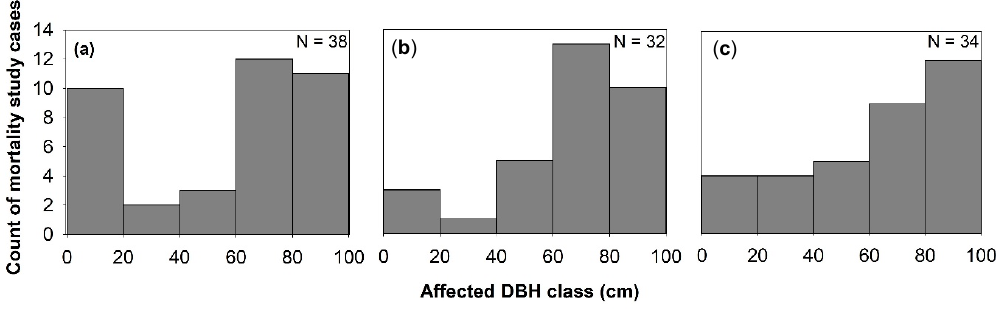
Figure 5. Windstorms e ff ects on mortality across diameter at breast height (DBH) classes in ( a ) TRF, ( b ) SUF, and ( c ) TEF. N is the total number of articles that belong to each forest zone, and only studies that used % mortality were